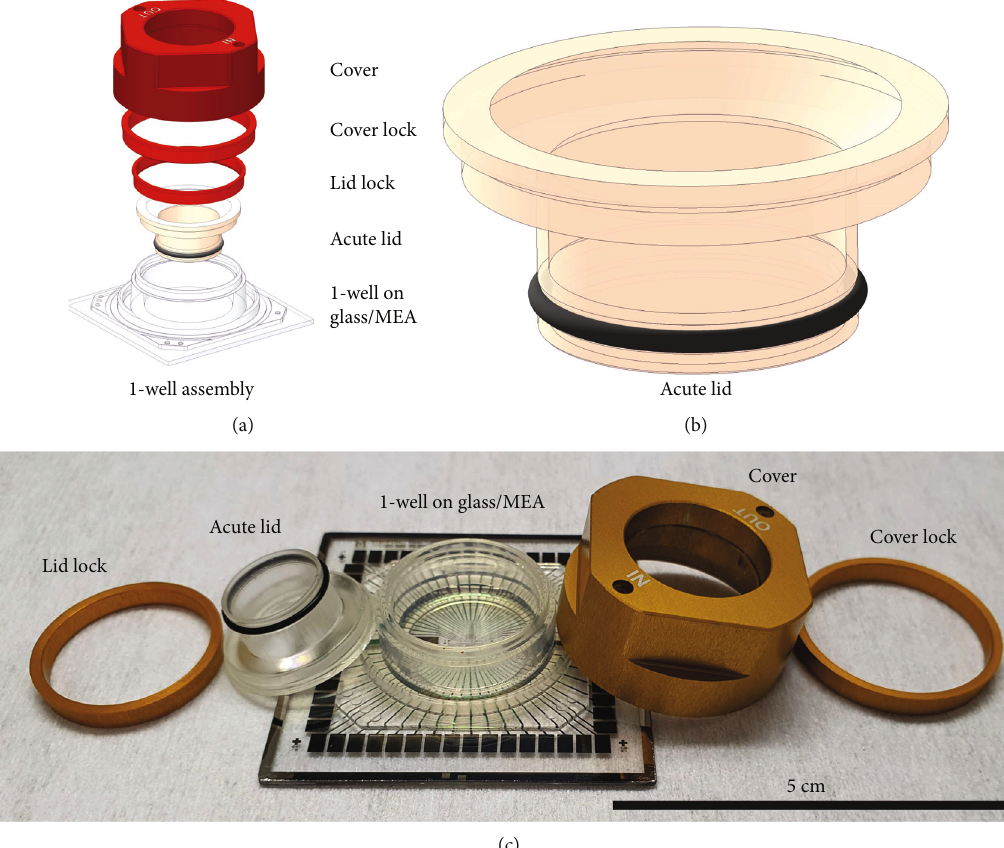
Figure 1: 1-well assembly and acute lid. (a) Illustration of the 1-well assembly. The Acute lid is attached to 1-well assembly and sealed against the silicone injection moulded 1-well structure with a lid lock. The assembly is covered with a cover that is locked tightly to the assembly with a cover lock. (b) Illustration of the acute lid. The acute lid consists of a hollow cylinder covered with a gas permeable polyethylene membrane attached with an O-ring. (c) A real image of the 1-well assembly and the acute lid (scale bar 5